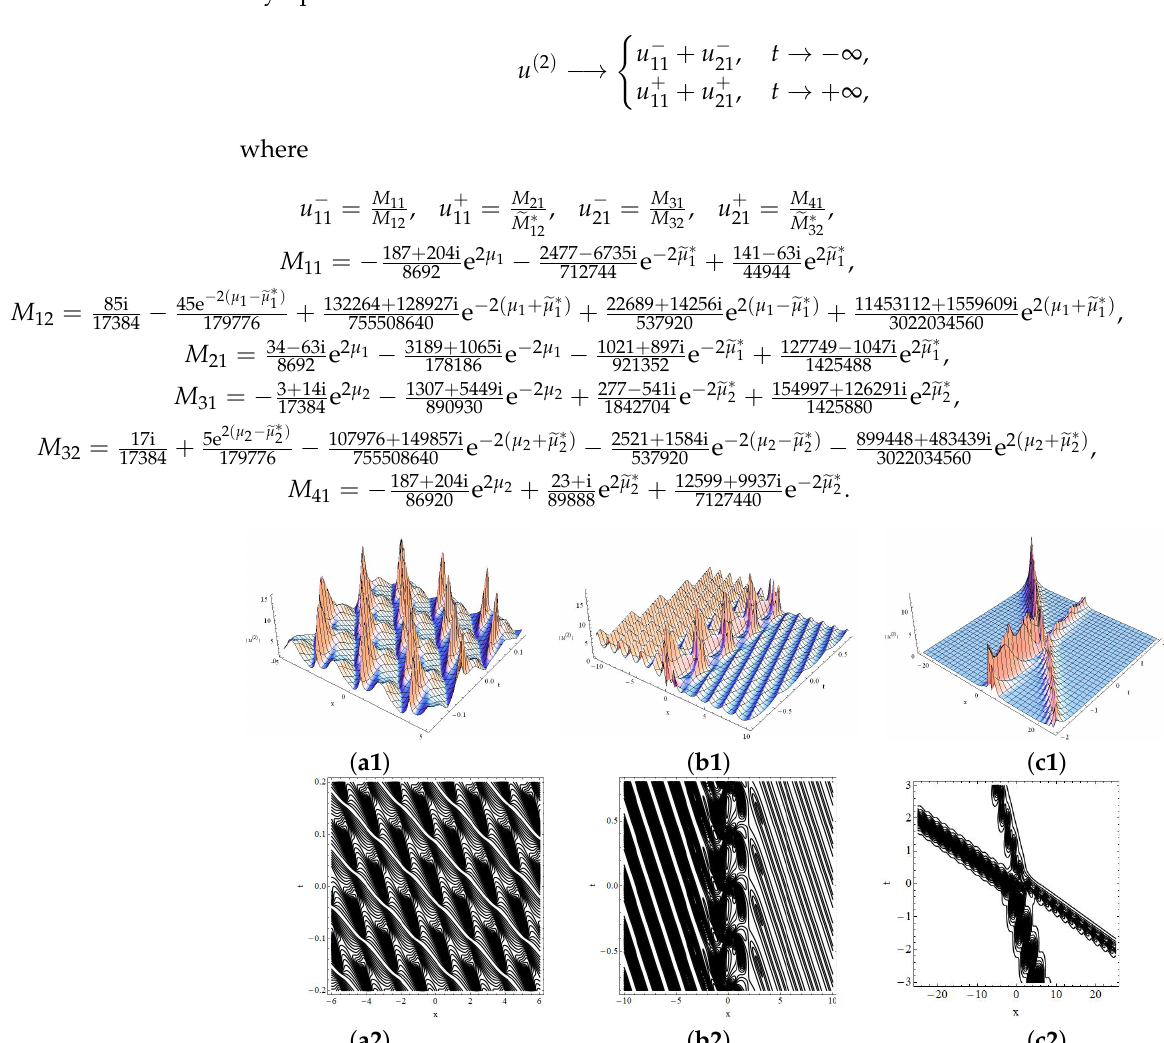
Figure 5. Interaction solutions for Equation (5) with a = − 1, b = i c 5 = 0: ( a ) interaction of two periodic waves with c 6 = 2i, λ 1 = 1, λ 2 = 2; ( b ) interaction of KM- breather-like and periodic wave with c 6 = 1, λ 1 = 1, λ 2 = 1 and breather wave with c 6 = 1, λ 1 = 1 + i